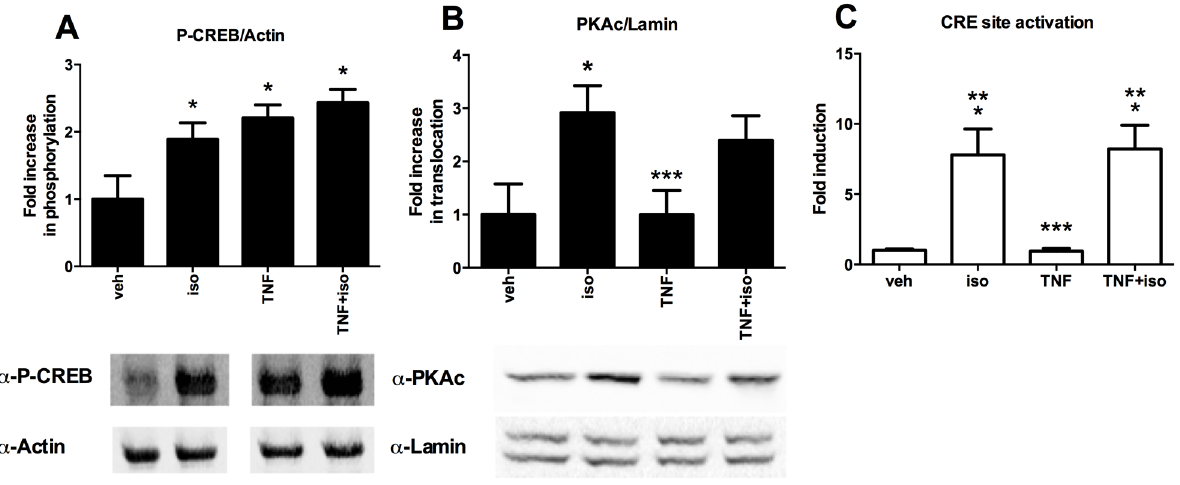
Figure 4. Effect of isoproterenol/TNF- a cotreatment on activation of the PKA/CREB cascade. (A) Increase in phosphorylation of CREB at serine 133. After induction of C2C12 myotubes for 15 minutes with veh, iso and/or TNF, cells were lysed in SDS sample buffer and analysed via Western blotting. Bar charts represent average 6 SD of densitometric analysis of three independent experiments. A representative blot is shown. (B) Effect on nuclear translocation of PKAc. After veh, iso and/or TNF treatment for 15 min, nuclear extracts were prepared and analysed via Western blotting. Bar charts represent average 6 SD of densitometric analysis of three independent experiments. A representative blot is shown. (C) Effect on the activation of CREB. C2C12 myotubes, transfected with the CRE-luciferase reporter plasmid, were treated with veh, TNF and/or iso for 6 hours, before analysis of luciferase production. Fold induction was calculated versus veh control. Results represent average 6 SD of three independent experiments. Statistical significance was determined via ANOVA followed by Bonferroni’s multiple comparison test (*) Significantly different from veh. (***) Significantly different from iso.